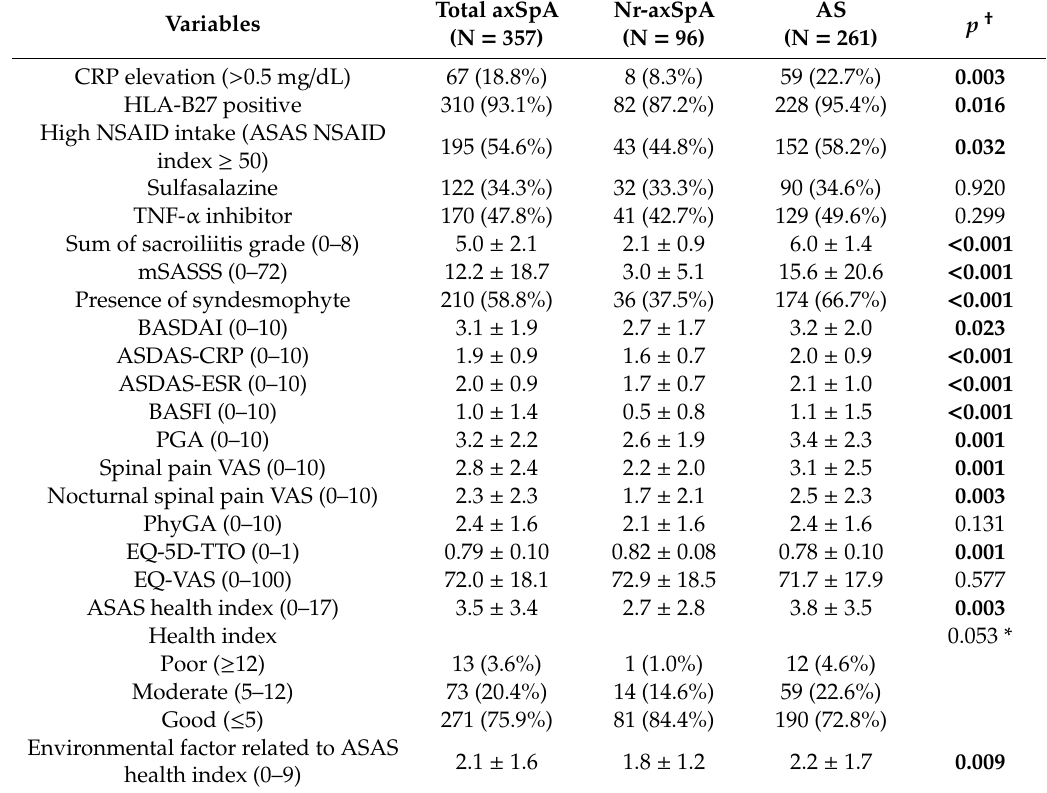
Table 2. Comparison of laboratory, radiographic, and axSpA related parameters between nr-axSpA and ankylosing spondylitis (AS).